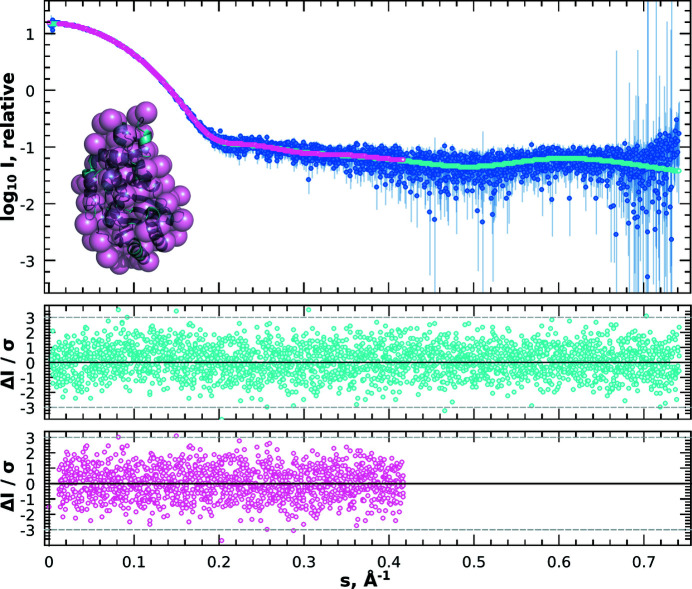
1D scattering data from beta-lactamase (PDB ID 5hw5) simulated by IMSIM and radially averaged with IM2DAT (dark blue), overlaid with the source data calculated by CRYSOL (cyan), and the corresponding fit of the ab initio model from DATMIF (pink). The inset shows the DATMIF bead model superimposed on the source model. The offset residual plots show random distribution of the residuals around zero within the expected bounds (±3). Corresponding goodness-of-fit statistics are reported in Table 1 ▸.